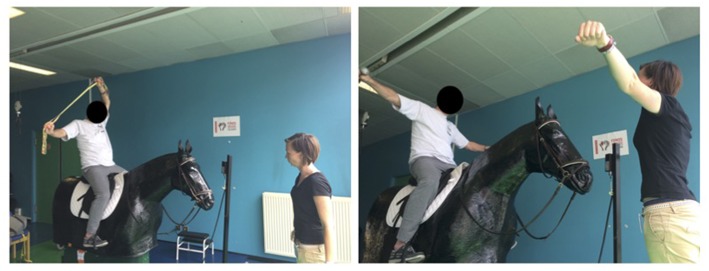
Example of exercises during training sessions.